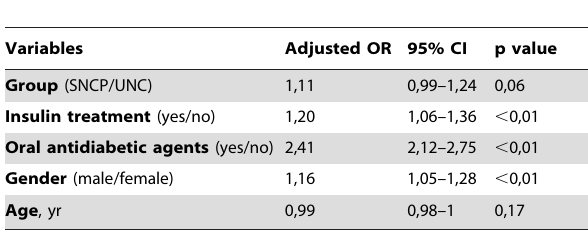
Table 3 show baseline characteristics of the study population. The two groups were homogeneous in gender, but not in age, and diabetes evolution time. Patients in the SNCP group had a higher prevalence of poorer personal health habits (drinking and sedentary physical activity), dyslipidemia and complications Table 6. Associated factors with HbA1c , 7% in 12,800 DM patients with baseline HbA1c $ 7%: logistic regression